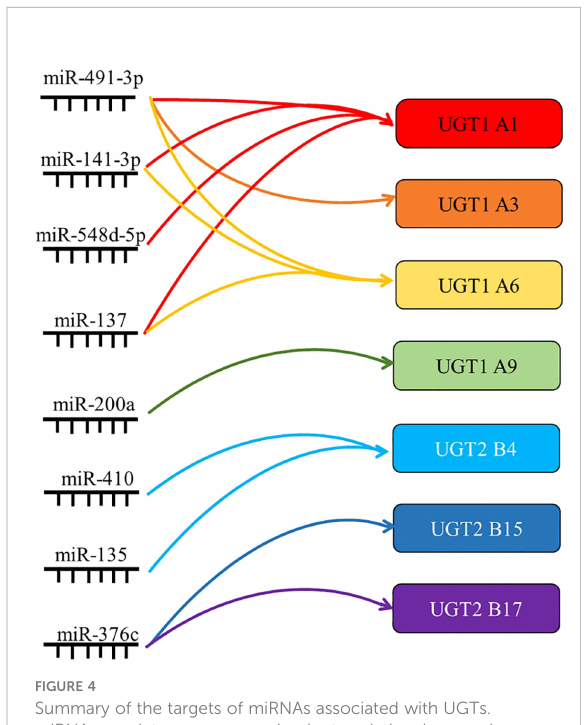
FIGURE 4 Summary of the targets of miRNAs associated with UGTs. miRNAs regulate gene expression by translational repression or degradation of mRNAs through incomplete base pairing with target mRNAs. By summarizing the direct regulatory role of miRNAs, their indirect regulatory role and their role in drug metabolism and tumor progression, the most important UGTs targets are listed